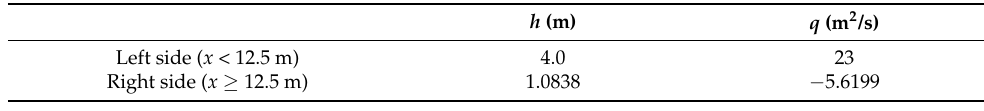
Table 2. Initial conditions for a homogeneous case of two shockwaves in a frictionless, horizontal channel.